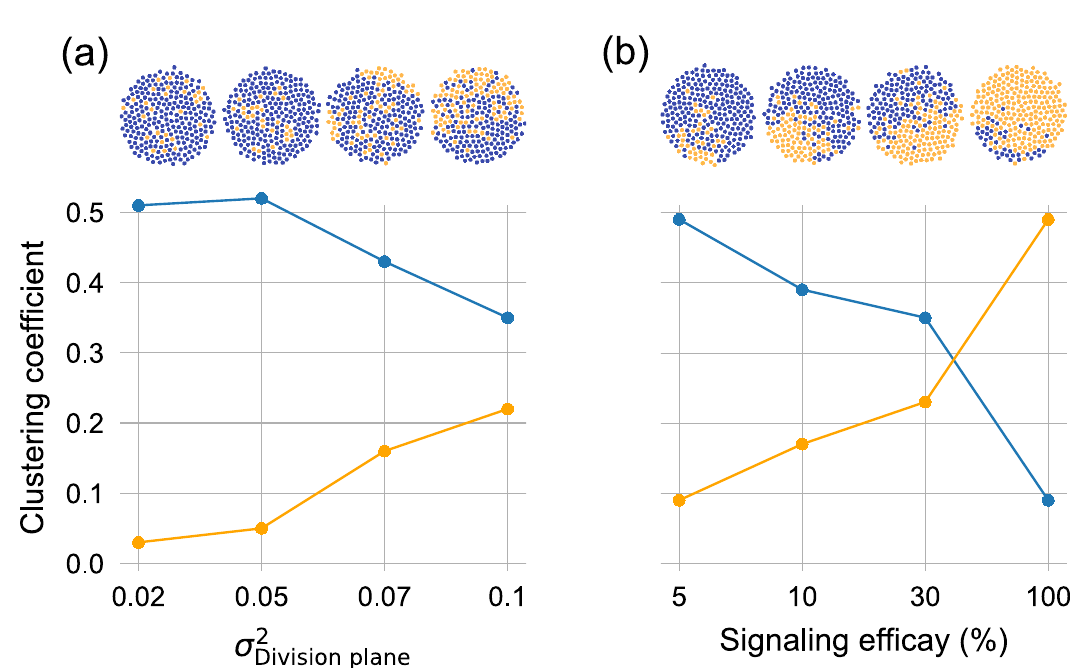
Fig 5. Upper panels: Population heterogeneity as a result of increase in: (a) the noise of the stochastic positioning of the division plane of cells (increase in the variance of the Normal distribution) or (b) the intensity of the secreted signals from the B cells. Both the number of TFs in (a) and the efficacy of signaling in (b) increases from left to right in this figure. The blue circles represent the A cells and the orange ones represent the B cells. Each aggregation is the final state of a single run of the stochastic model after 8 generations with the given parameters, starting from a blue cell. The amount of protein X in the initial cell in each simulation was 35. The radius of the area of aggregation is 100 μm . Bottom panels: The change in the global clustering coefficient of both cell types as a result of change in the (a) noise of the stochastic positioning of the division plane of cells and (b) intensity of the signaling molecules secreted by orange cells. In the latter case, the variance of the noise in the division plane of cells is fixed to the 0.05 of the cells radios. The blue curves stands for A cells and the orange curves for B